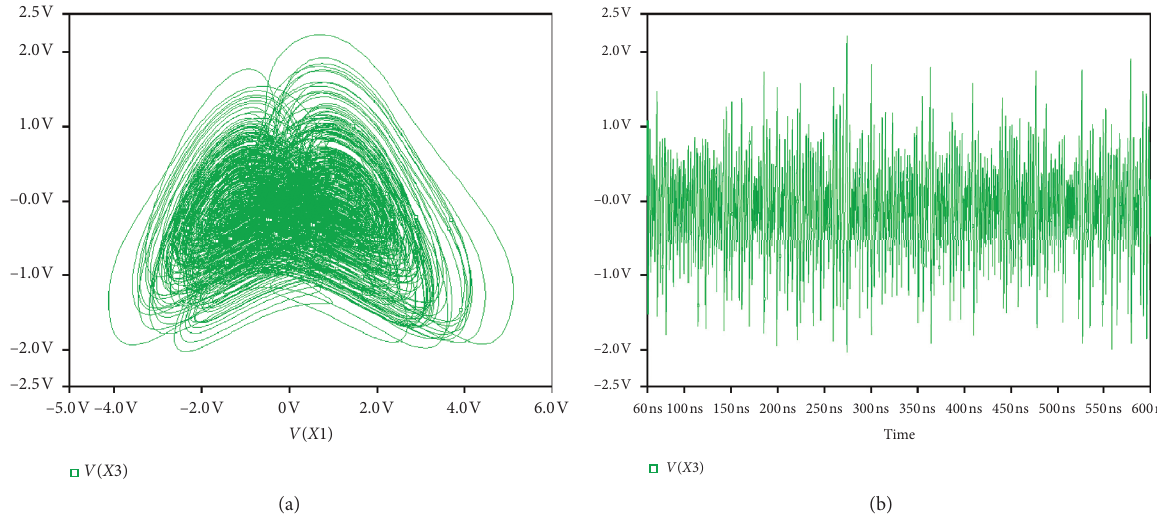
Figure 13: Chaotic behavior of system (2) observed for R